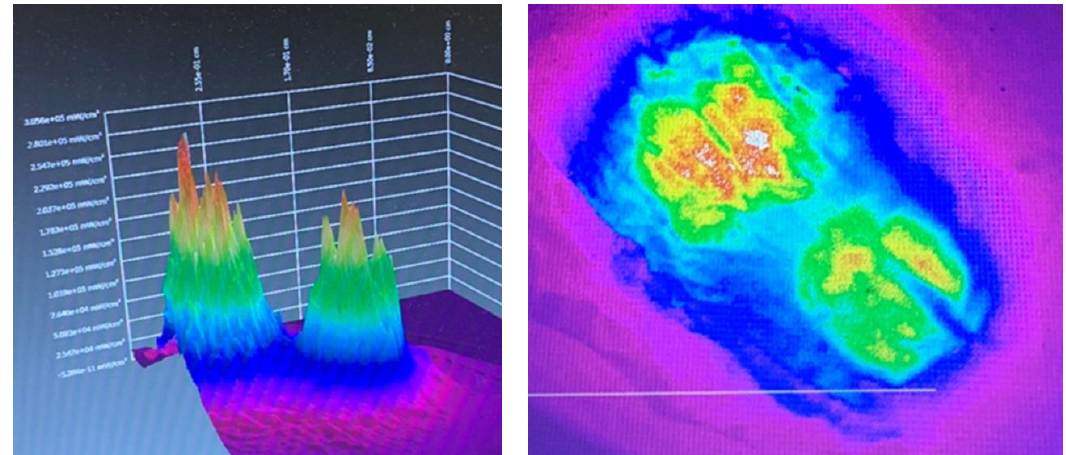
Figure 4. Three-dimensional render ( left ) and planar view ( right ) of the beam profile of two parallel optic beams 1 cm apart applied to a tissue sample. These images are offered as a guide to the reader to demonstrate the lack of lateral spread from the tips. Note the Gaussian distribution and the relative lack of lateral scatter.